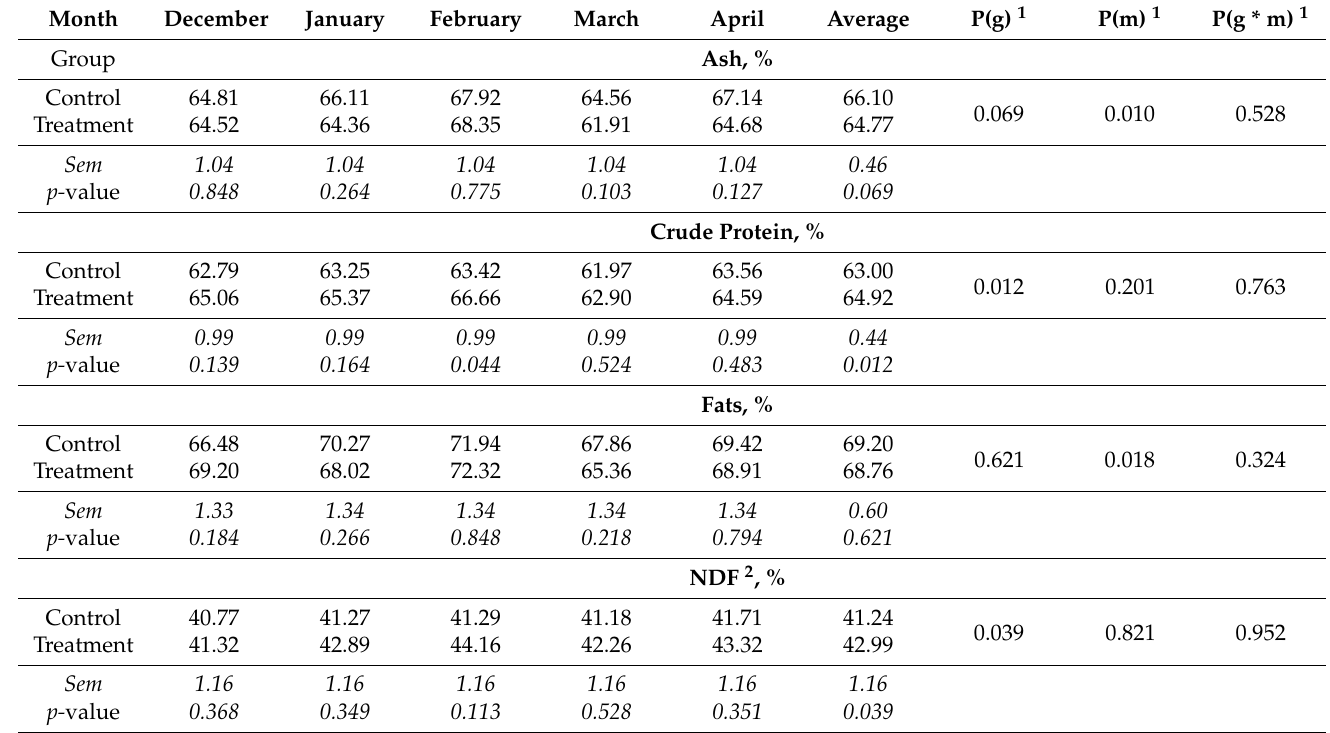
Table 8. Digestibility in the two